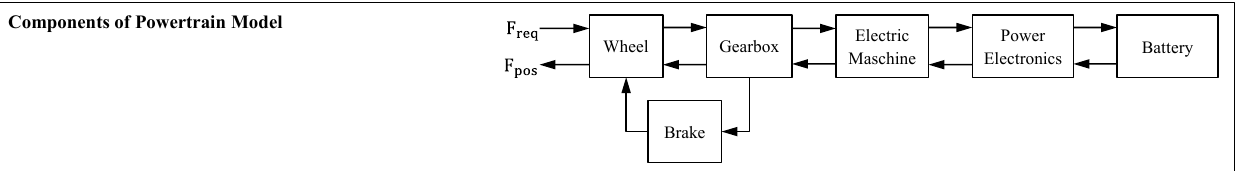
Figure A3. Components of the suggested powertrain model for energy consumption estimation. Based on the required tractive force at the wheelbase, the required torque T wheel,req is calculated via the dynamic wheel radius. The transmission model considers the gear ratio, i g , and a constant efficiency, η gear